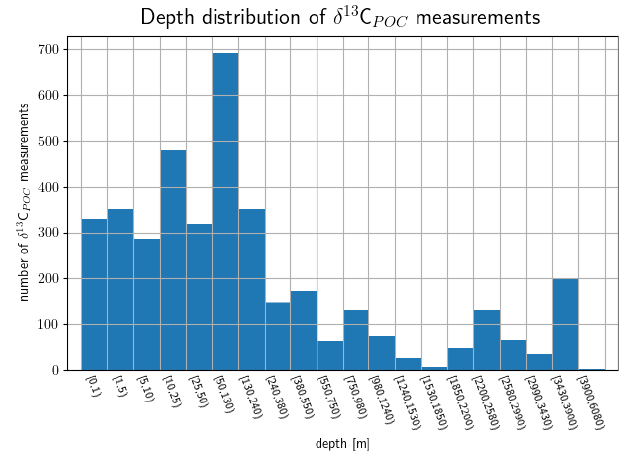
Figure 4. Vertical data coverage in depth layers based on the UVic grid: the uppermost 50m is divided into subranges; below they are according to the UVic grid. The number of δ 13 C POC data points available is plotted against its respective depth